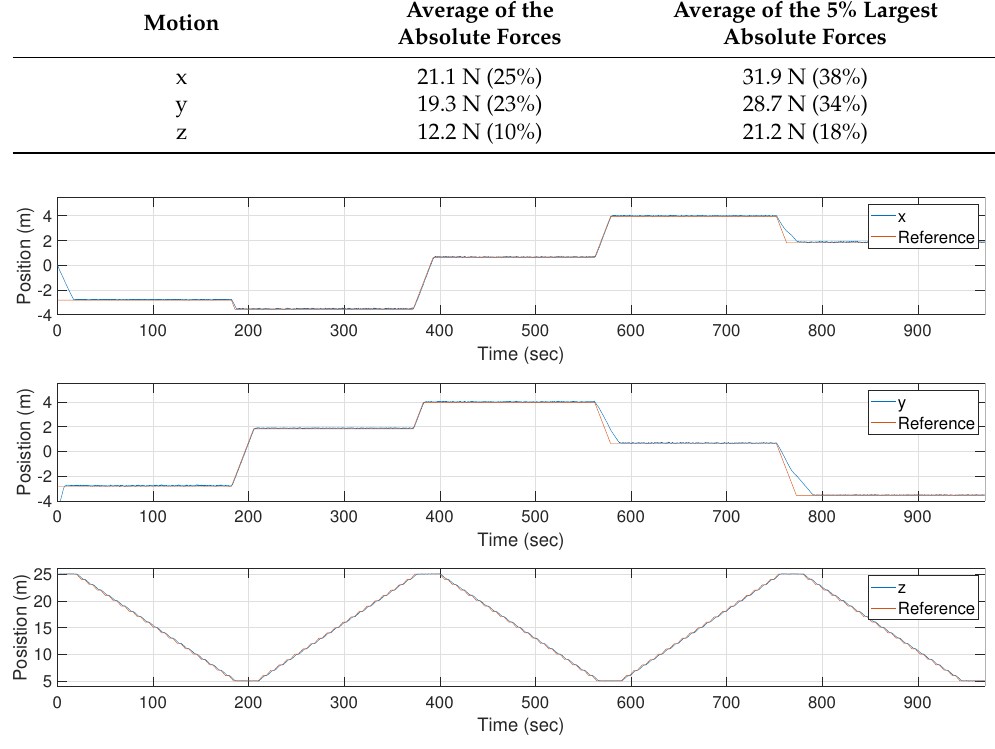
Figure 13. Position in x,y and